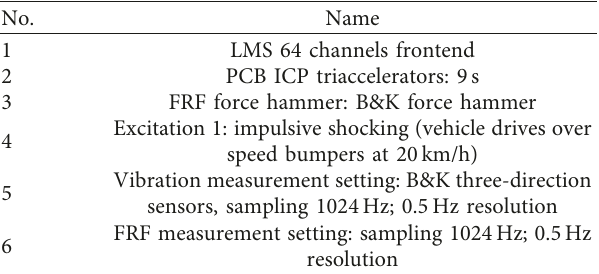
Table 3: Measurement